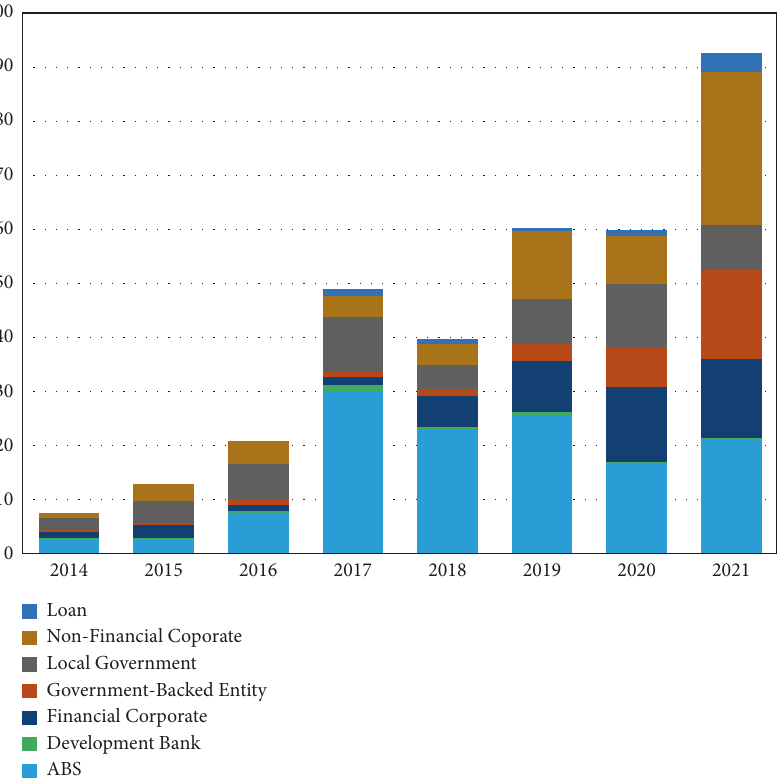
Figure 7: Type of Green Bond Issuers in the US from 2014 to 2021 (Data source: Climate Bonds